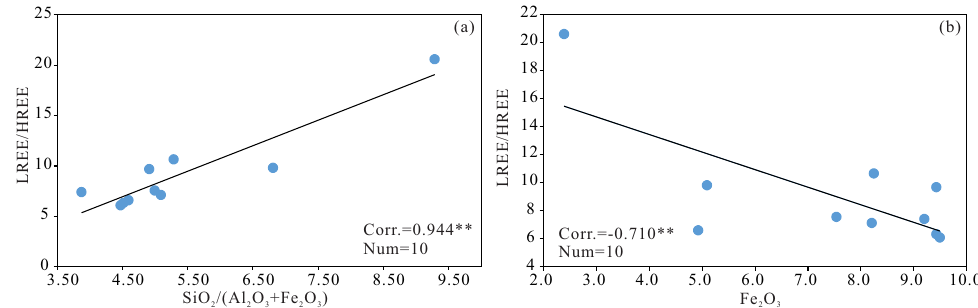
Figure 7. Scatter diagram of ( a ) SiO 2 /(Al 2 O 3 +Fe 2 O 3 ) versus LREE/HREE and ( b ) Fe 2 O 3 versus LREE/HREE in profile 2. ** p <